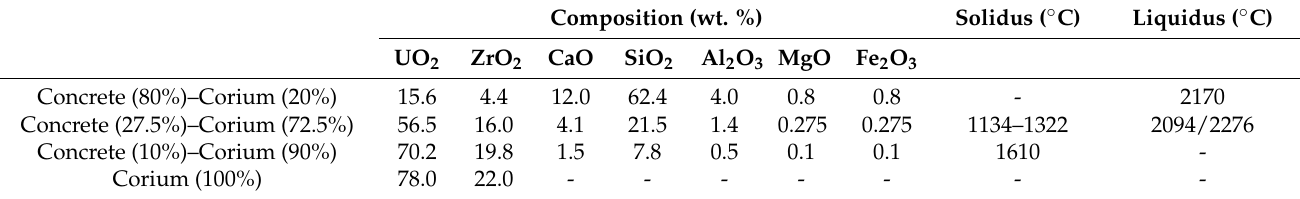
Table 4. Corium–siliceous concrete compositions and measured solidus and liquidus temperatures [143]. Composition (wt. %)